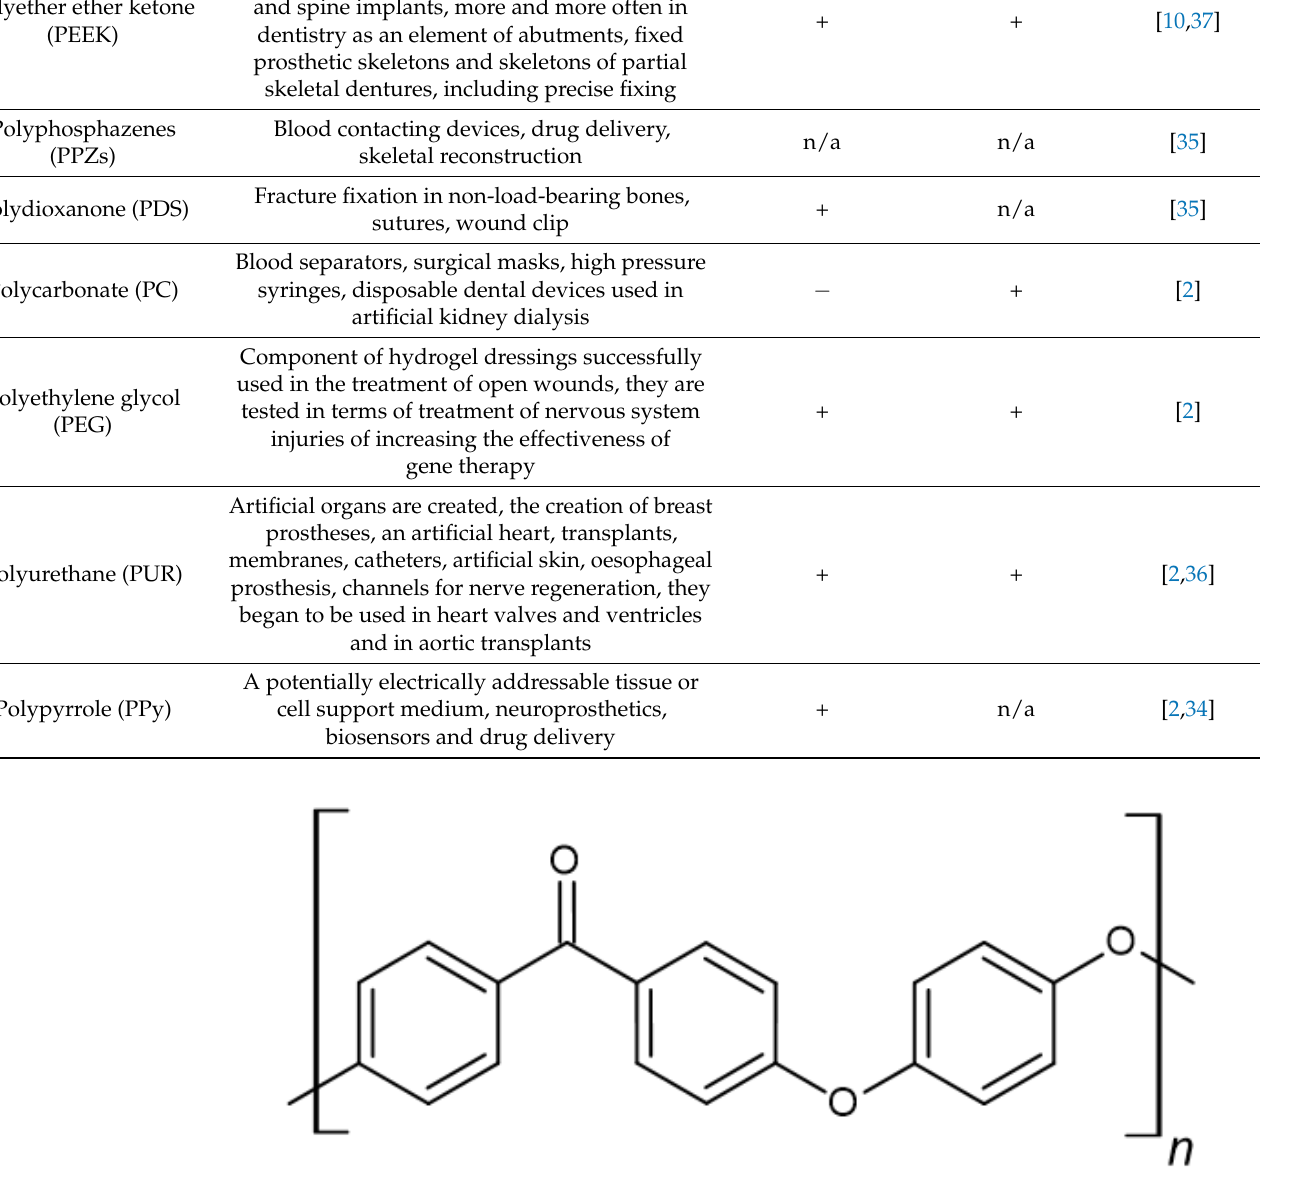
Figure 2. Polyether ether ketone structure.